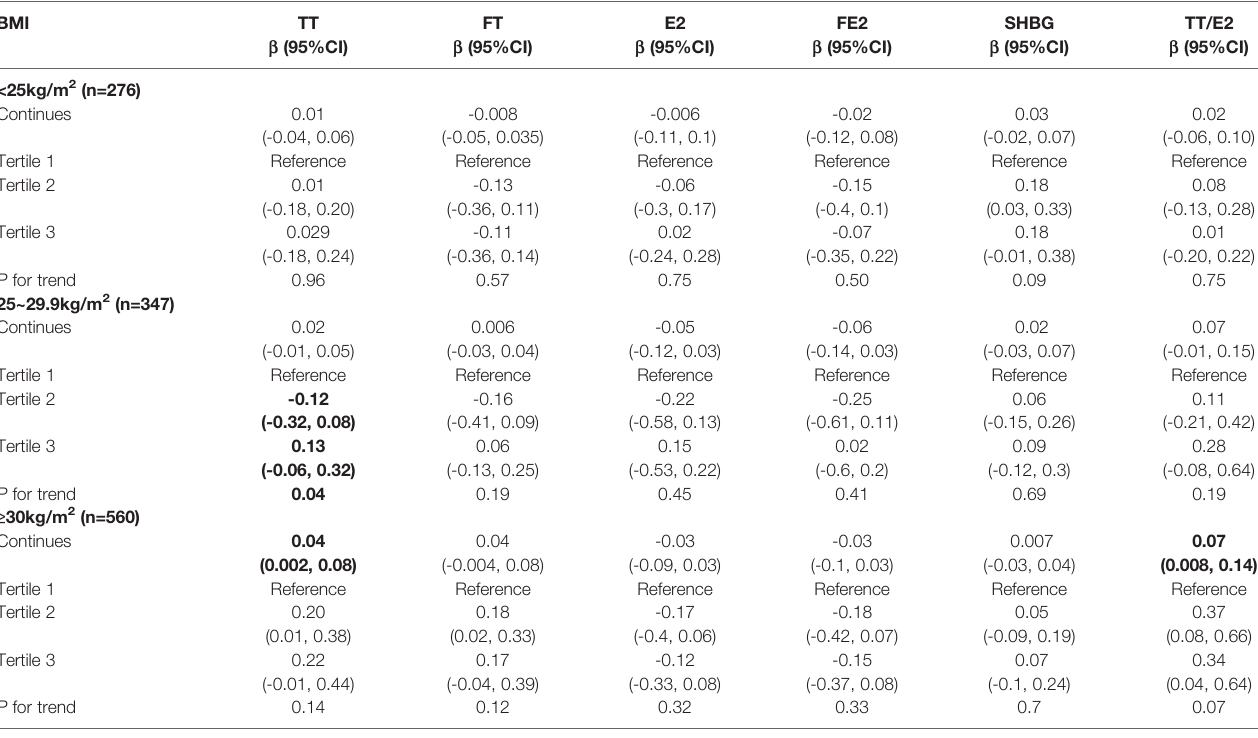
TABLE 4 | Association between E-DII and sex hormones strati fi ed by BMI.